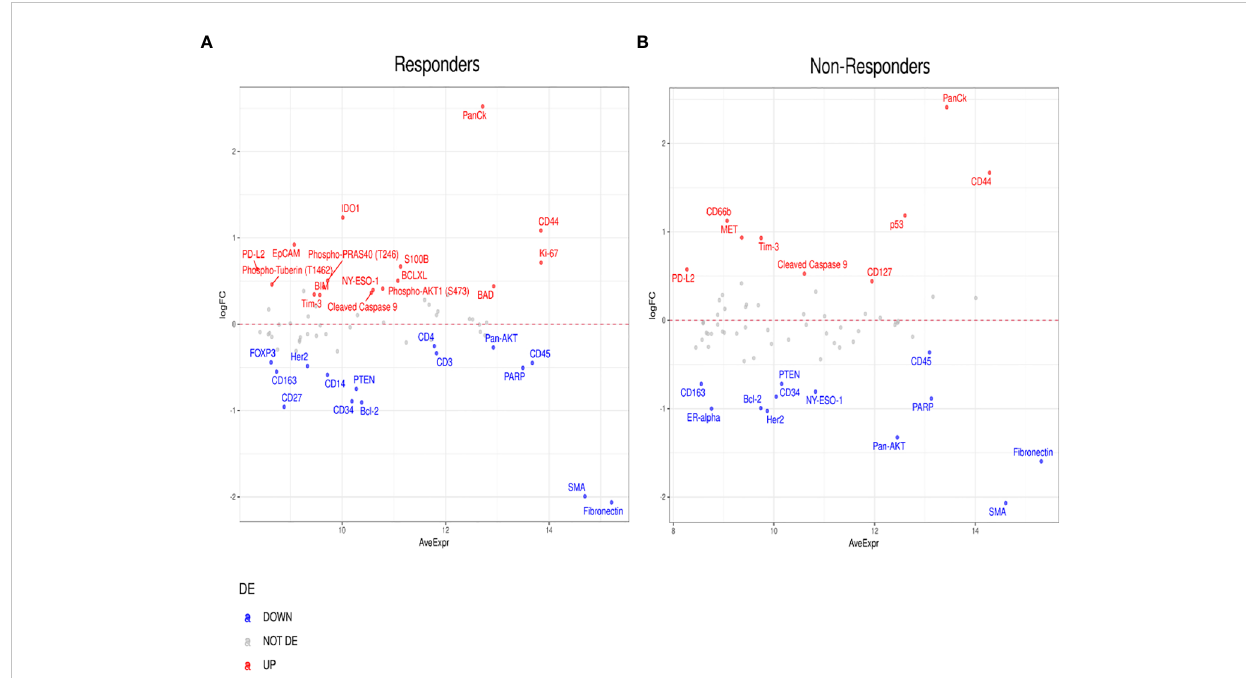
FIGURE 7 Differential protein expression between tumor and stromal compartments in different treatment outcomes. (A, B) MA plots of Mean Expression (AveExpr) vs fold change (logFC) visualizing expression of protein biomarkers in tumor compartment compared to stromal compartments in